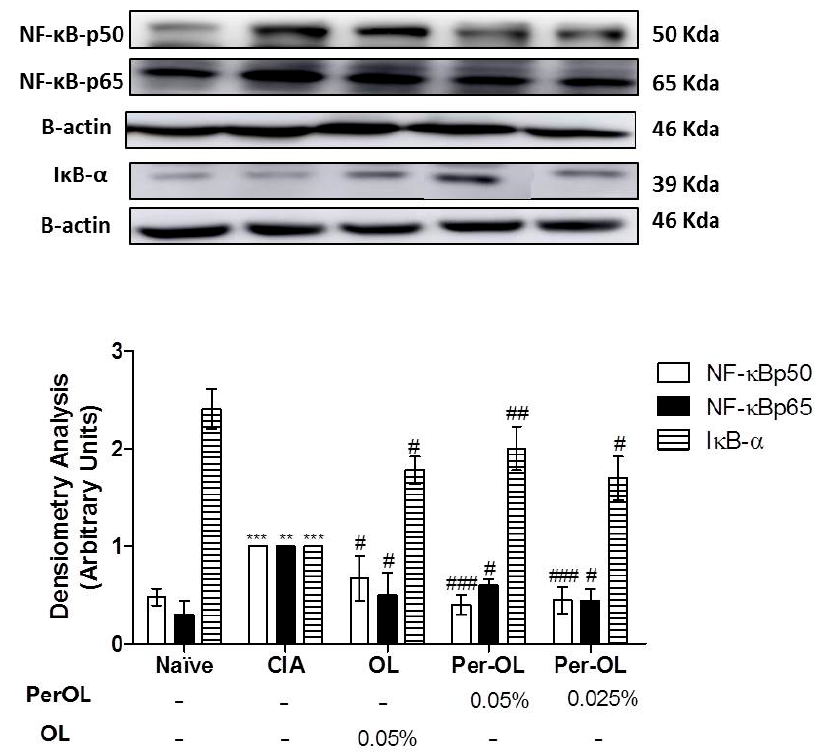
Figure 5. Protein expression of NF- κ B-p65 and –p50 in nuclear fraction and I κ B- α in cytoplasmic fraction of homogenates from hind paws. The expression was quantified by densitometry analysis and normalized with respect to a house-keeping β -actin. Data represent mean ± S.E.M., n = 5. ** p < 0.01 and *** p < 0.001 vs. SD-Naïve control group, # p < 0.05, ## p < 0.01 and ### p < 0.001 vs. SD-CIA control group.